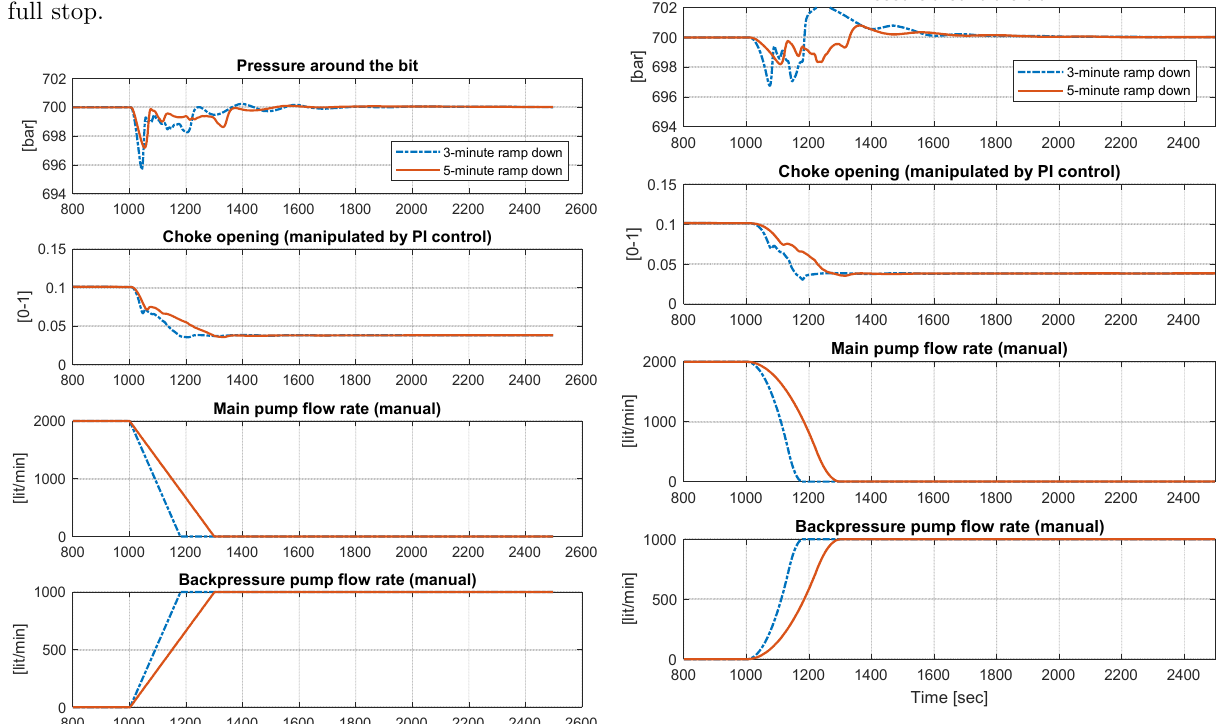
Figure 5: Pressure response while stopping the mud circulation with soft changes in the beginning and in the end of stopping